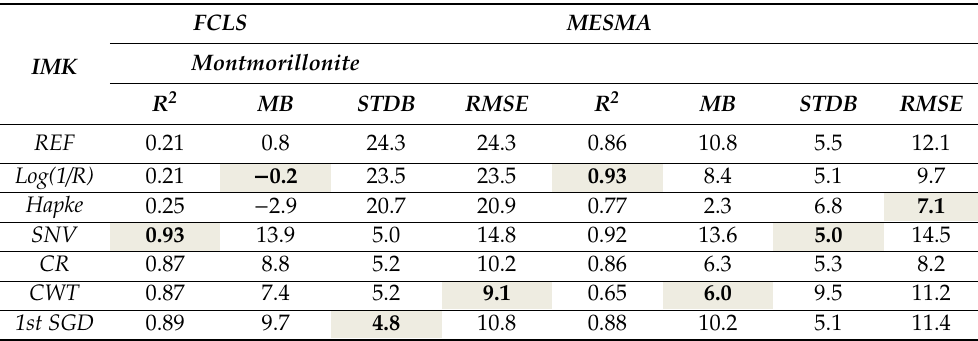
Table 5. Performances of linear unmixing methods to estimate montmorillonite abundances for illite-montmorillonite-kaolinite (IMK) intimate mixtures with di ff erent combinations of spectral preprocessings (best results in grey cells with bold font).